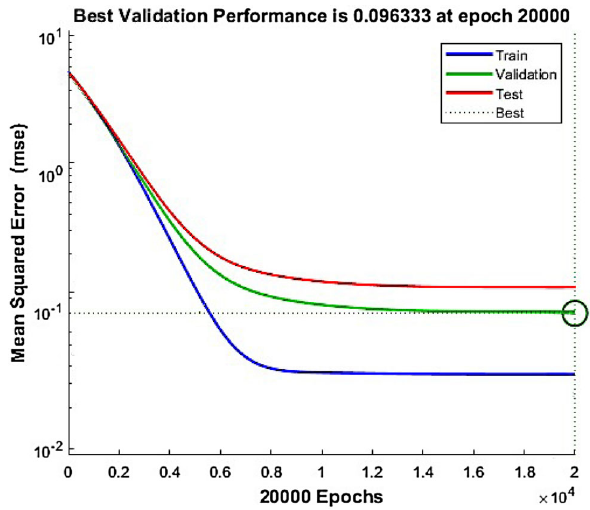
Fig. 12 Performance of the spatial stagnant water prediction model in training and testing predicting the accumulation of water at high-risk points in the study area, the same scenario simulation based on the PCSWMM hydrological and hydrodynamic model was performed using the same computer. The time required to run the simulations of the two models are shown in Table 6. For a rainfall event that lasts for 2 hours, the water accumulation prediction based on the physical model required approximately 15 minutes, while the rapid pre- diction model required approximately 20 seconds. Even if